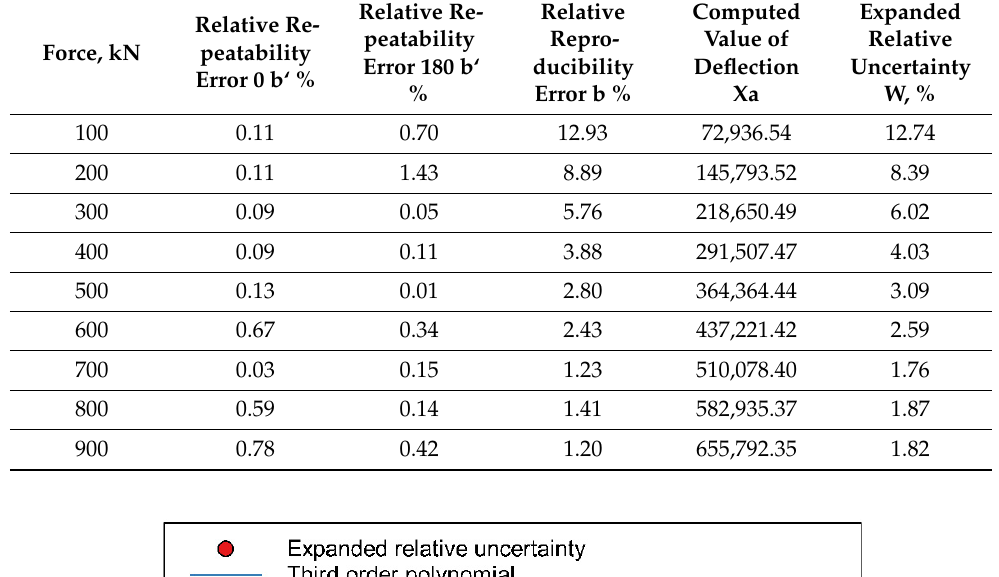
Table 3. Error and uncertainty determination results.